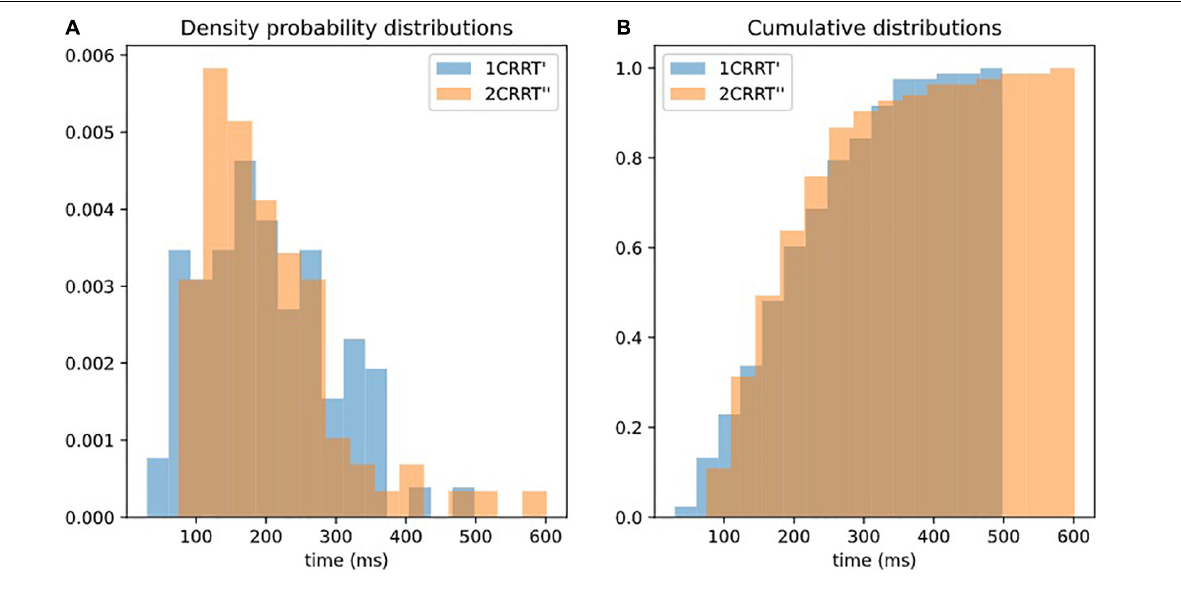
FIGURE 4 | Superposition of distributions of 1CRRT (cid:48) and 2CRRT (cid:48) . After re-scaling 2CRRT for difficulty, the 2 distributions 1CRRT (cid:48) and 2CRRT (cid:48) are superposed. KS, d = 012, p = 0.59.The standard deviations also become equal and the whole distribution over the 83 subjects is the same (the Kolmogorov–Smirnov test gave d = 0.12, p = 0.59 against the hypothesis of different distributions). Our findings can be interpreted as a confirmation that the difficulty corresponds to a scaling parameter. (A) Distribution of 1CRRT (cid:48) and 2CRRT (cid:48)(cid:48) are superposed. (B) View of the cumulative distribution of 1CRRT (cid:48) and 2CRRT (cid:48)(cid:48)